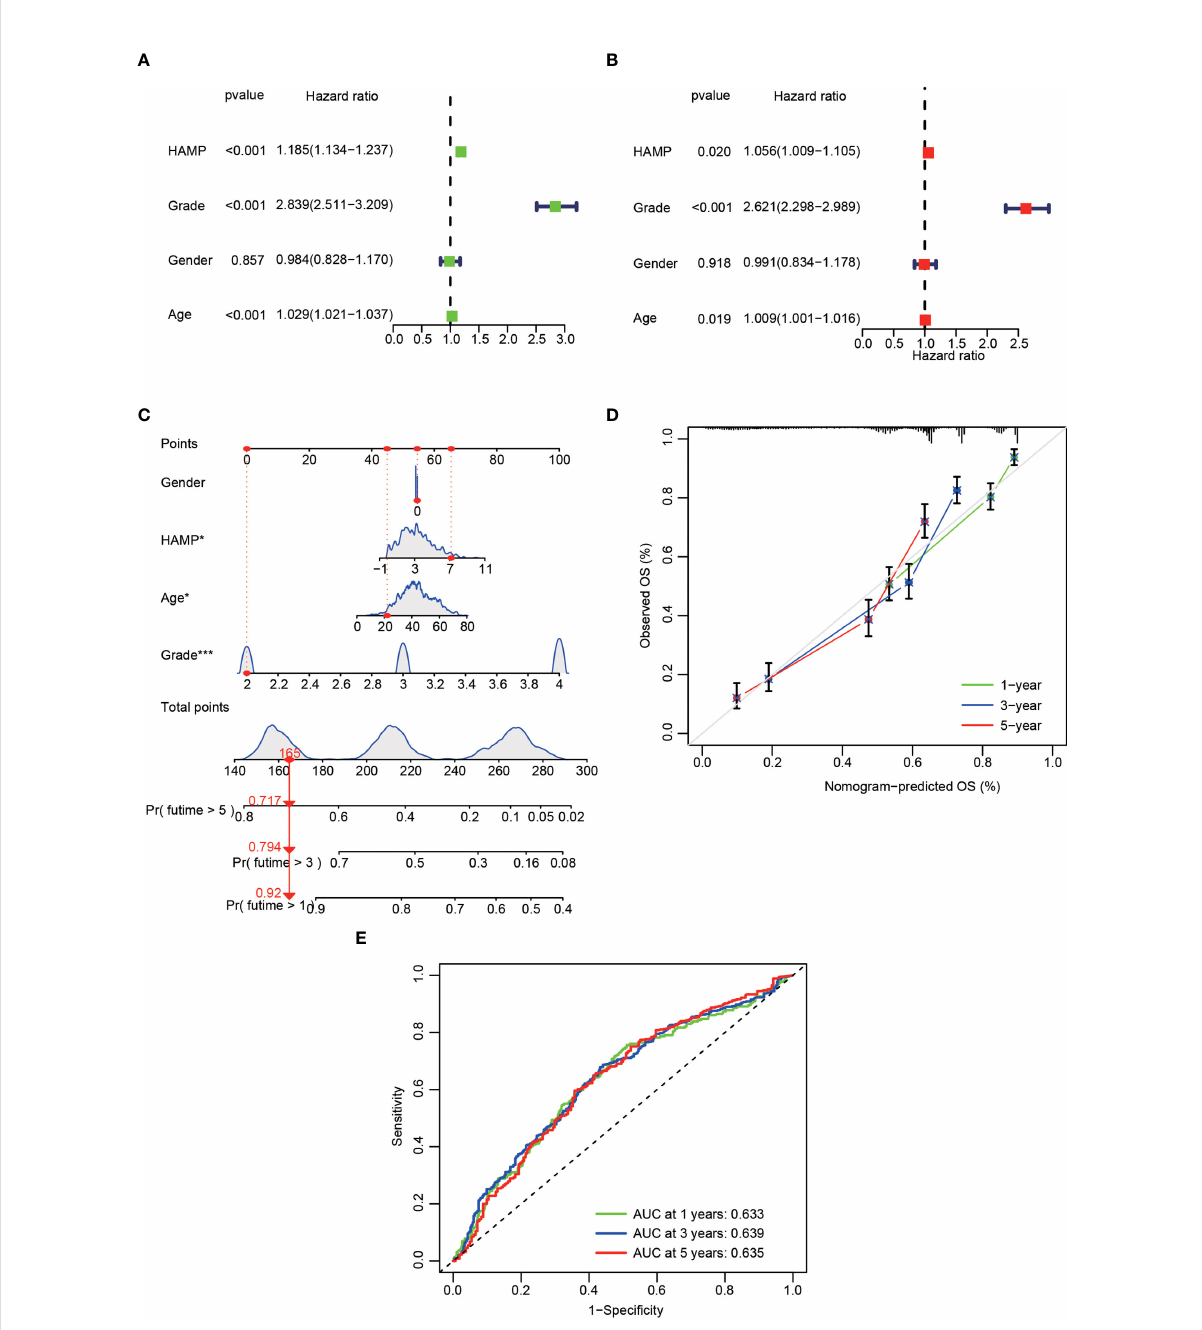
FIGURE 4 Cox regression analysis and establishment of a prognostic model using the CGGA dataset. (A) Univariate analysis of hepcidin expression in the CGGA dataset. (B) Multivariate analysis of hepcidin expression in the CGGA dataset. (C) The nomogram was constructed based on four factors for predicting 1- year, 3-year or 5-year survival of patients with glioma in the CGGA database. (D) The calibration plots of internal validation in CGGA dataset showed good consistency in predicting 1-year, 3-year or 5-year survival. (E) The 1-year, 3-year and 5-year ROC curves for the CGGA dataset. *p < 0.05 and ***p <